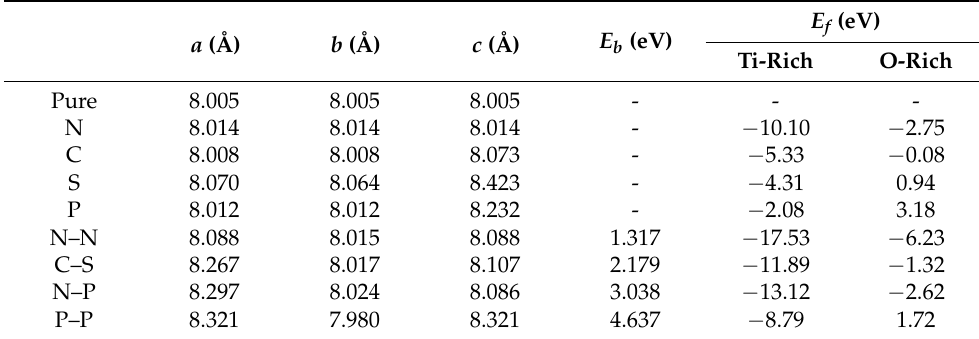
Table 1. The optimized lattice parameters, and the formation of energy for pristine and mono- and co-doped BaTiO 3 .